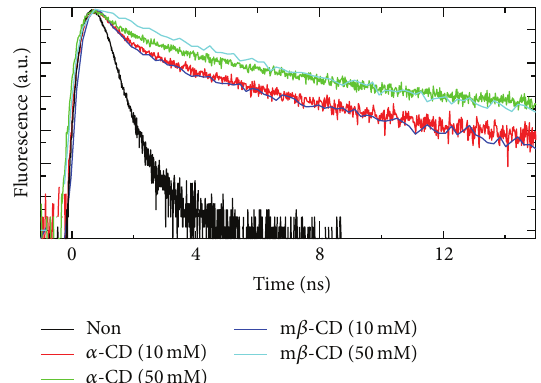
Figure 5: Representative time profiles of fluorescence lifetimes of DE in the absence (black line) and the presence of 𝛼 -CD (10mM, red line; 50mM, green line), or m 𝛽 -CD (10mM, blue line; 50mM, cyan line) in ACN or H 2 O/ACN (9: 1),